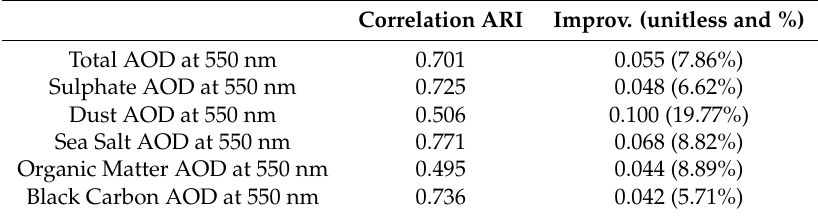
Table 3. Mean values of Pearson time correlation coefficients for Aerosol Optical Depth at 550 nm (AOD550) for the base case simulation (ARI) with the CAMS reanalysis and improvement of the Pearson correlation coefficient with respect to the base case simulation when including ACI. A positive value of the improvement indicates an increase in the correlation in the ACI simulation with respect to the base